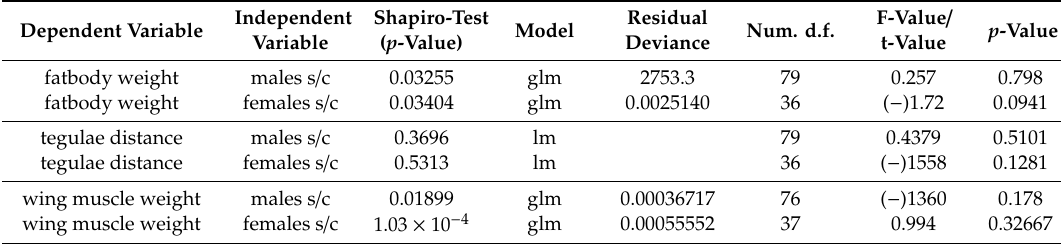
Table 3. Physiological state tests of hatched imagines (males / females) from spore-treated and control